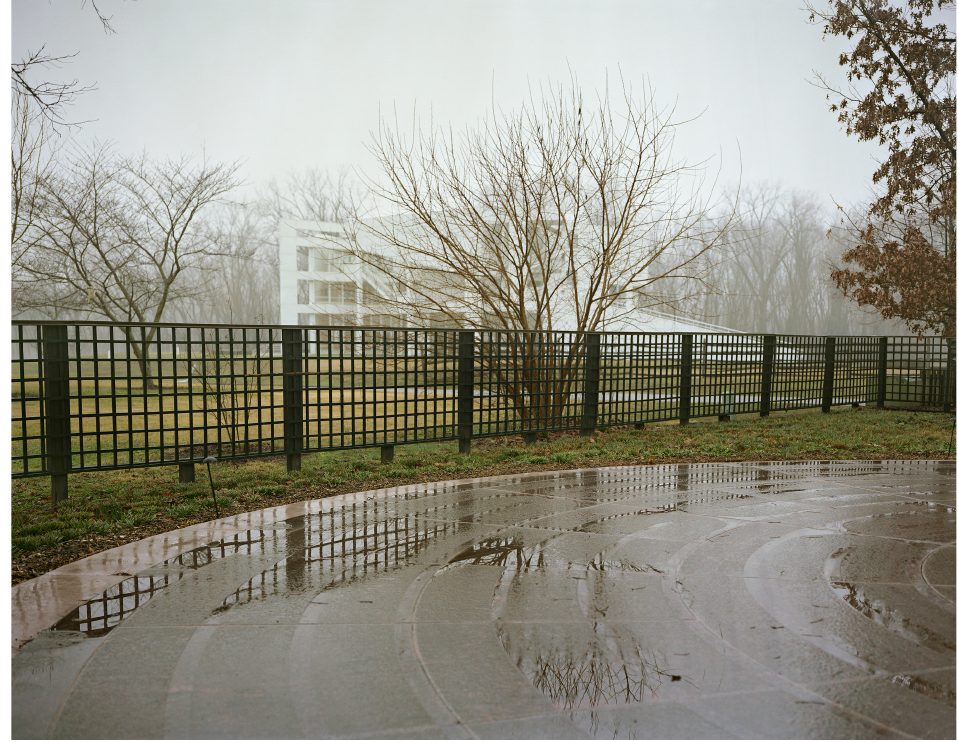
Regina Mamou, Chartres Cathedral , 2012. Digital C-Print, 40 x 50 in. (photo: courtesy of the